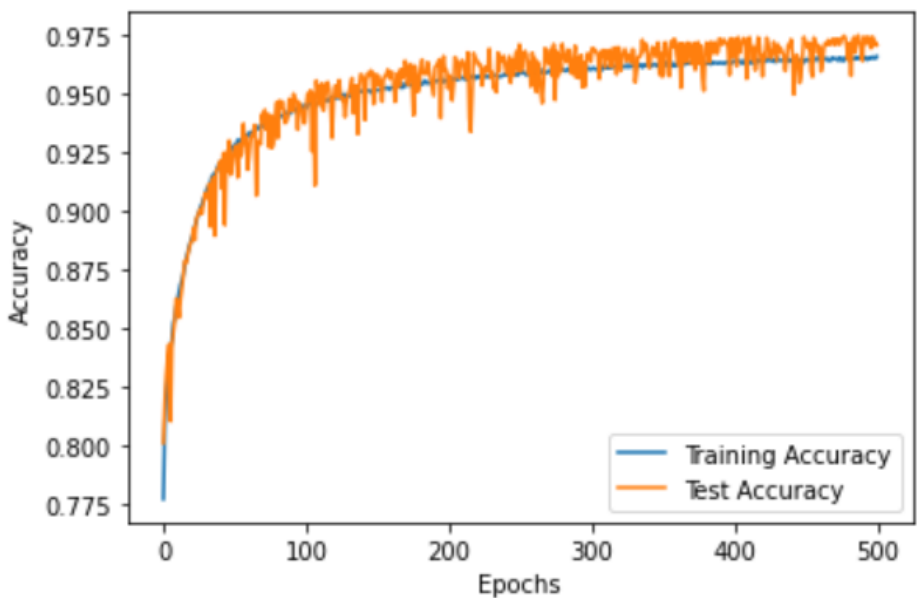
Figure 4. The accuracy curve for the EMG data classification of the right side using the proposed CNN architecture.